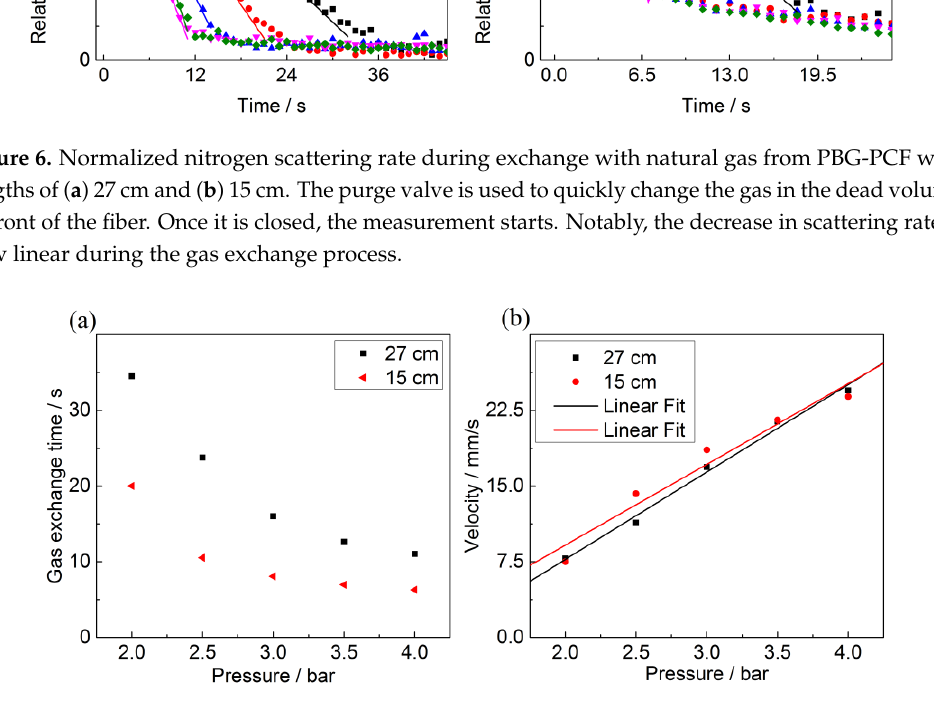
Figure 7. ( a ) Gas exchange time of the PBG fiber as a function of the input pressure when employing the purging valve; ( b ) Gas exchange velocity for various pressures and fiber lengths of 15 cm and 27 cm, respectively.